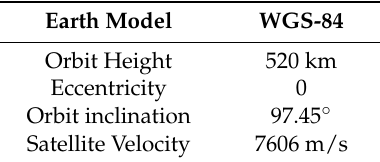
Table 1. Orbital